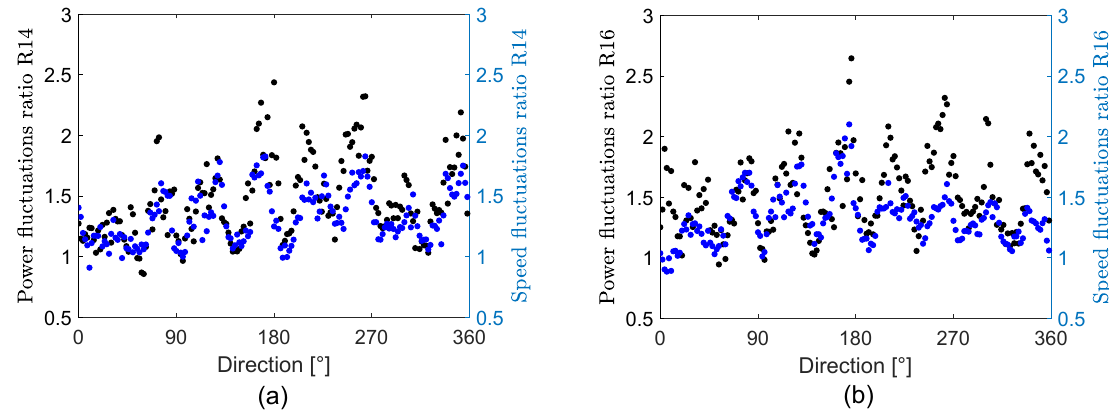
Figure 6. Ratio of fluctuations between in-wake and free-flow wind turbines for ( a ) R14 and ( b )